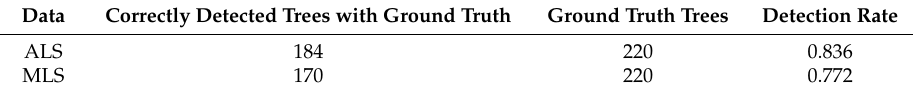
Table 1. Single tree detection results with ALS and MLS